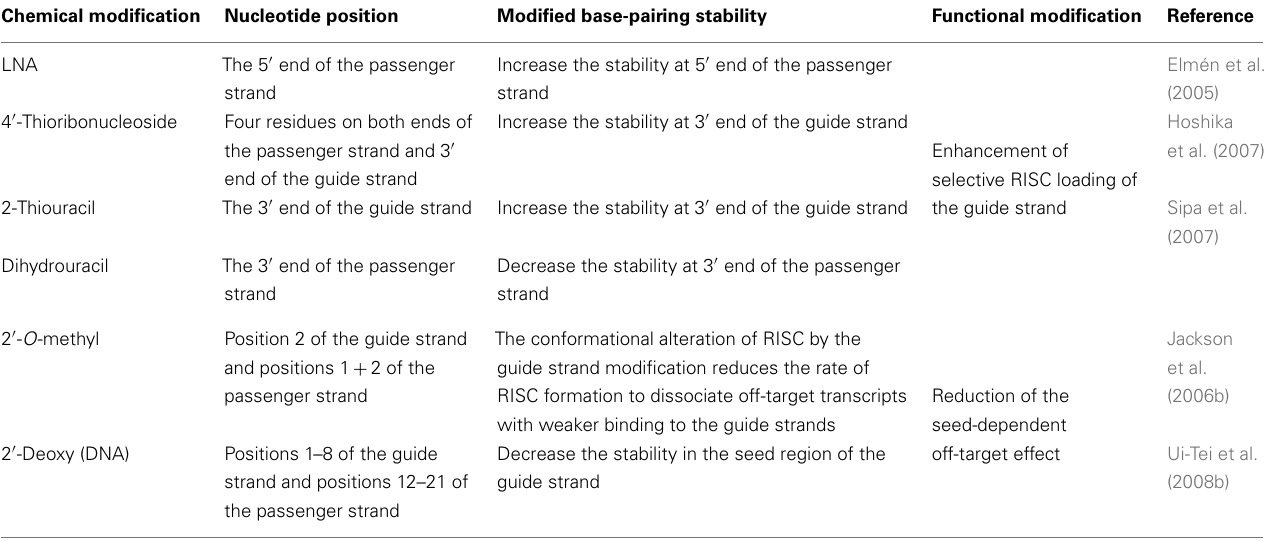
Table 2 |Thermodynamic siRNA modification.